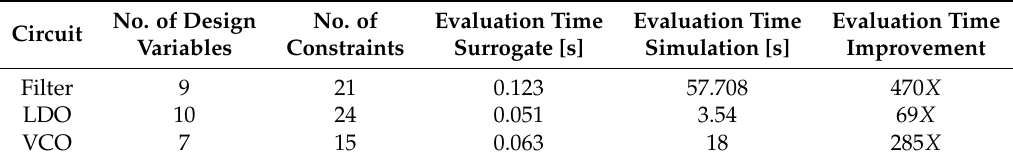
Table 7. Summary of the test cases under optimization using the proposed surrogate model. Circuit